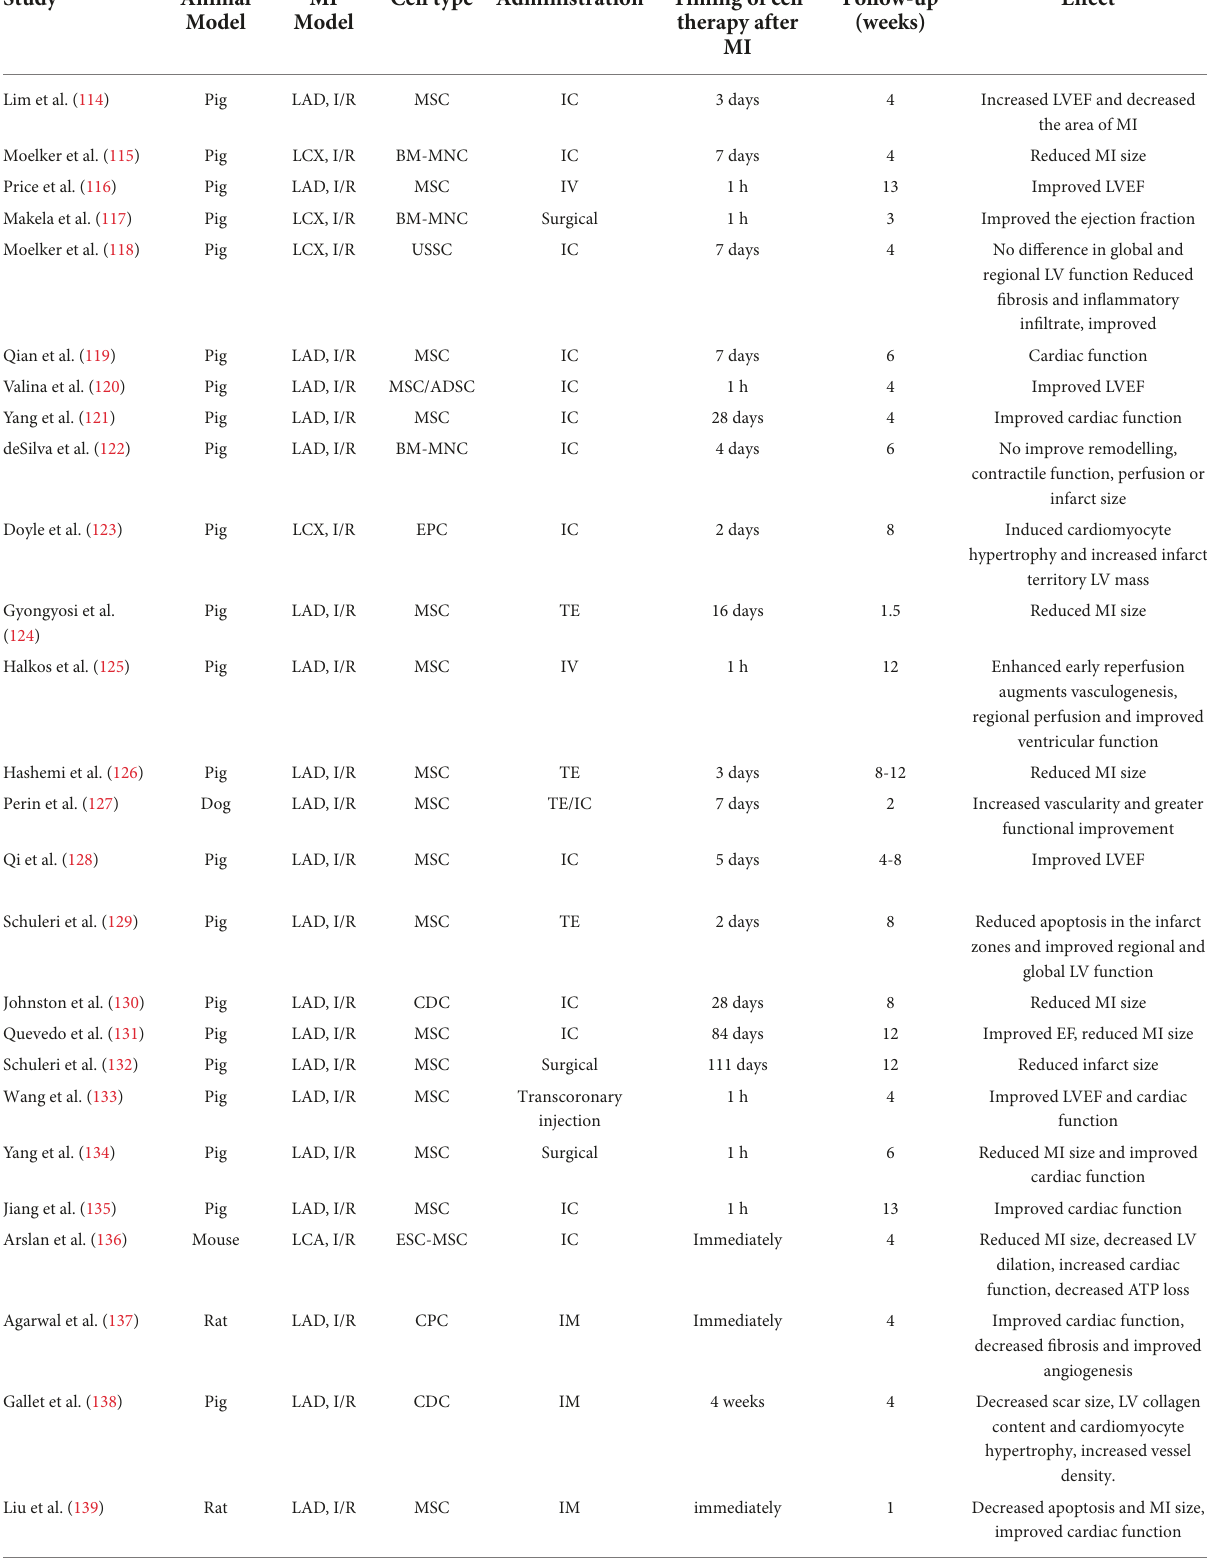
TABLE 4 Pre-clinical studies of stem cell therapy for cardiac